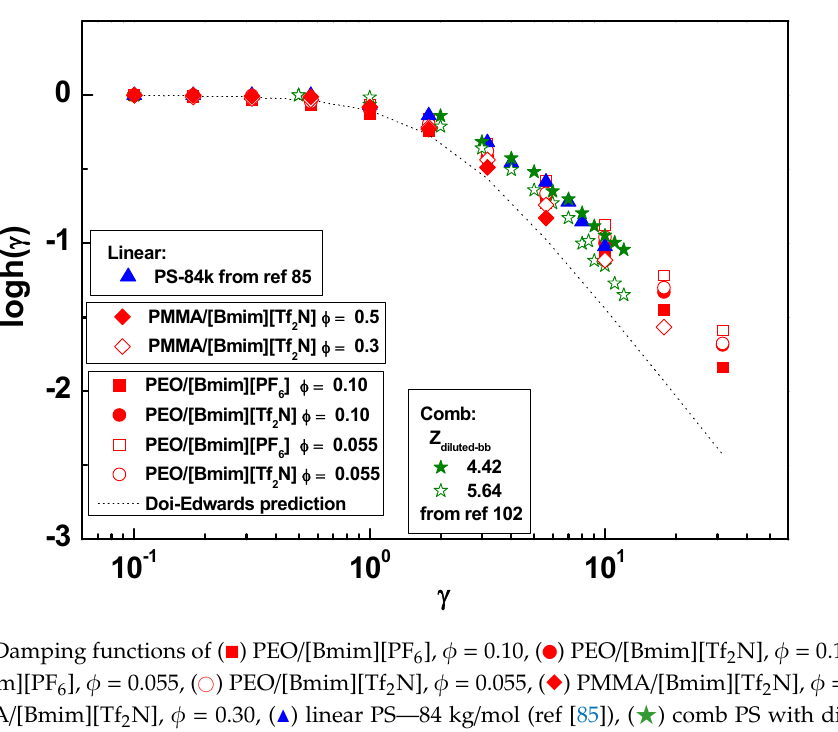
Figure 7. Damping functions of ( ■ ) PEO/[Bmim][PF 6 ], ϕ = 0.10, ( ● ) PEO/[Bmim][Tf 2 N], ϕ = 0.10, ( □ ) PEO/[Bmim][PF 6 ], ϕ = 0.055, ( ○ ) PEO/[Bmim][Tf 2 N], ϕ = 0.055, ( ◆ ) PMMA/[Bmim][Tf 2 N], ϕ = 0.50, ( ◇ ) PMMA/[Bmim][Tf 2 N], ϕ = 0.30, ( ▲ ) linear PS—84 kg/mol (ref [85]), ( ★ ) comb PS with diluted backbone entanglement number Z diluted ‐ bb = 4.42 (ref [102]), and ( ☆ ) comb PS with diluted backbone entanglement number Z diluted ‐ bb = 5.64 (ref [102]). The dotted curve is the Doi ‐ Edwards prediction.